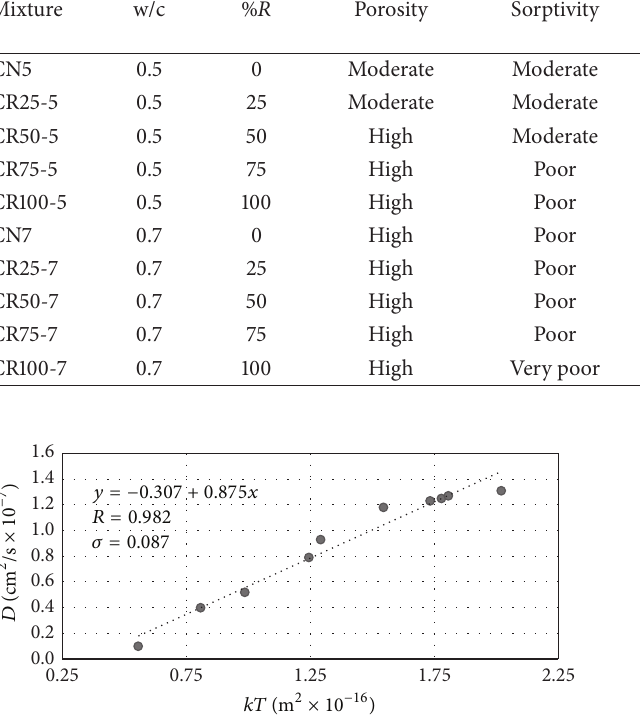
Figure 13: Chloride diffusion versus air